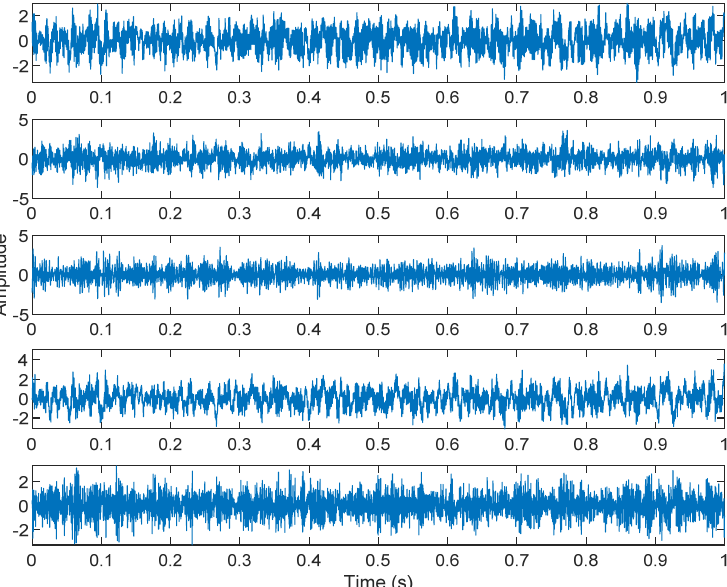
Figure 19. Analysis of data separated by VMD-ICA.